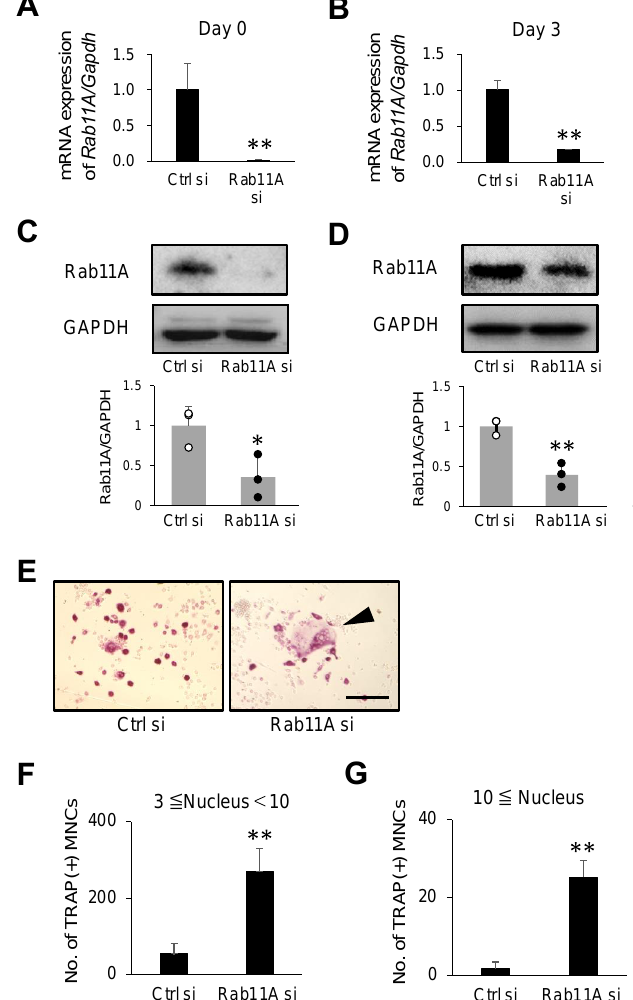
Figure 2. The effects of Rab11A silencing on osteoclast differentiation. ( A ) RAW-D cells were transfected with nontargeting (Ctrl) or Rab11A-specific siRNA for 24 h without RANKL stimulation. The knockdown efficacy of Rab11A mRNA was analyzed by qRT-PCR. ( B ) RAW-D cells were transfected with Ctrl si or Rab11A si for 24 h, followed by RANKL stimulation for 3 days. The knockdown efficacy of Rab11A mRNA levels was analyzed by RT-qPCR. ( C, D ) Upper: The endogenous level of Rab11A protein was assessed by WB on day 0 ( C ) and day 3 ( D ). Lower: Column scatter plotting to compare Rab11A protein level on day 0 ( C ) and day 3 ( D ). ( E ) TRAP staining of Ctrl si or Rab11A si-treated osteoclasts. The cells were treated with Ctrl si or Rab11A si 24 h, followed by RANKL stimulation for 3 days. An arrowhead indicated the mature osteoclasts. Scale bars: 200 μm. ( F, G ) The number of TRAP-positive osteoclasts with 3–10 nuclei ( F ), or with more than 10 nuclei ( G ) per viewing field was counted. * p < 0.05, ** p < 0.01, n = 3. Data are the representative of three independent